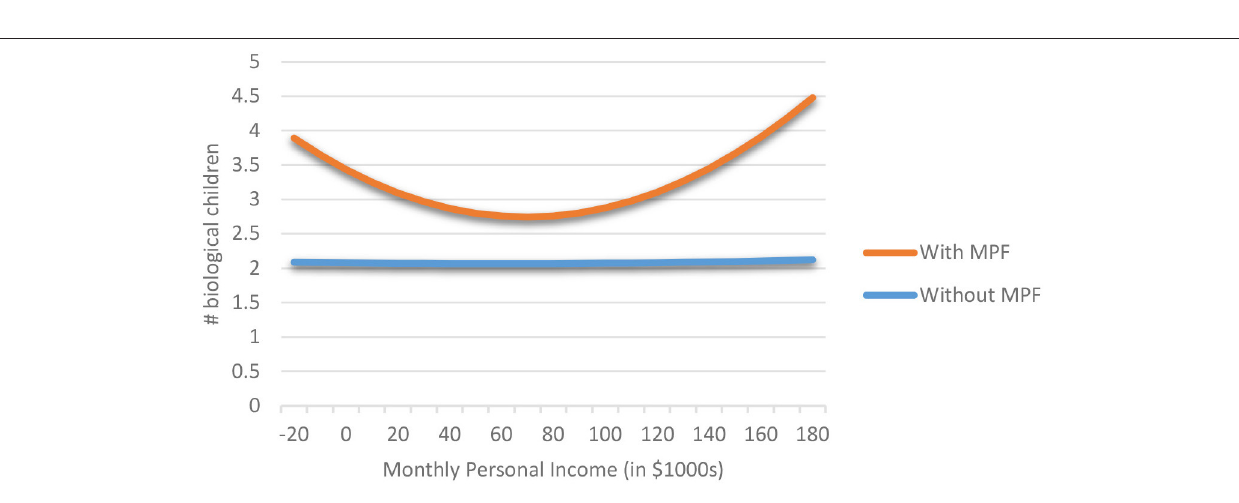
FIGURE 2 | Biological children, men with and without multipartner